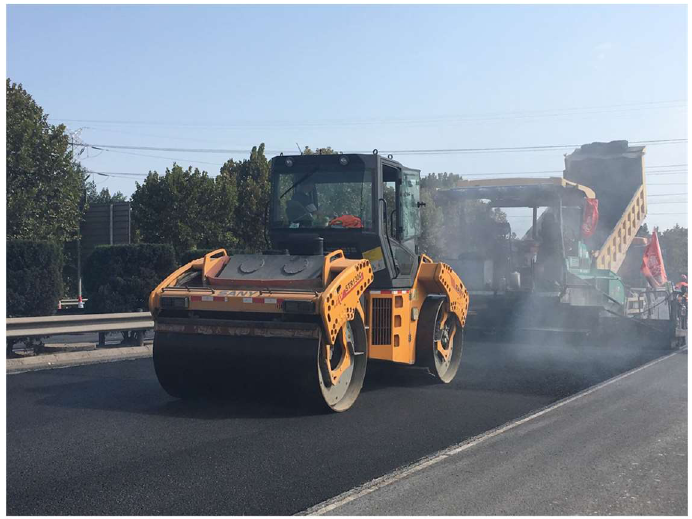
Figure 5. Mechanical equipment used for asphalt paving and compaction: pitch paver and road roller.